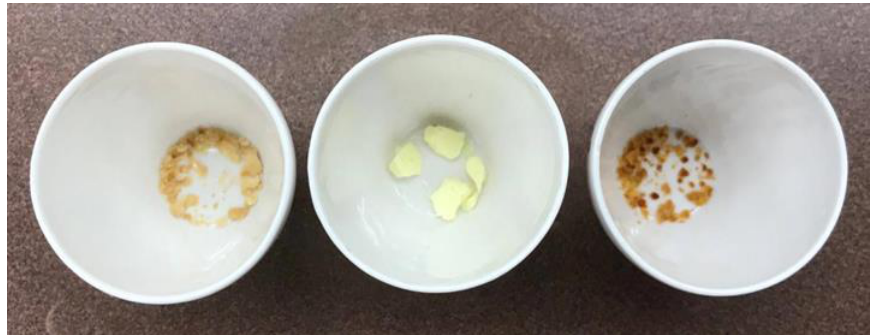
Figure 1. PGE salts from left (Pd, Pt, and Rh) produced by reacting PGE metal powder with potassium bisulfate in a muffle furnace at 550 °C for 3 h.